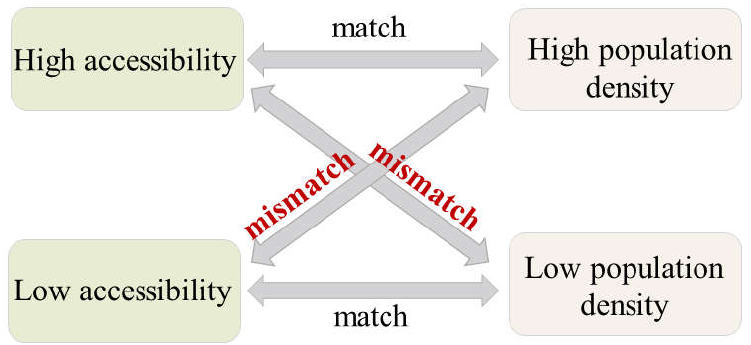
Figure 5. Distribution balance measurement of medical service facility accessibility.